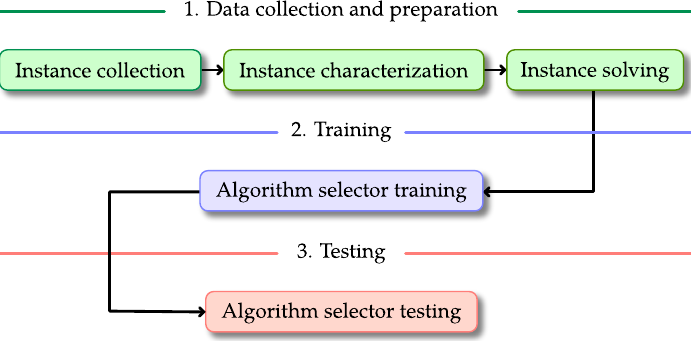
Figure 3. A graphical description of the proposed solution model.